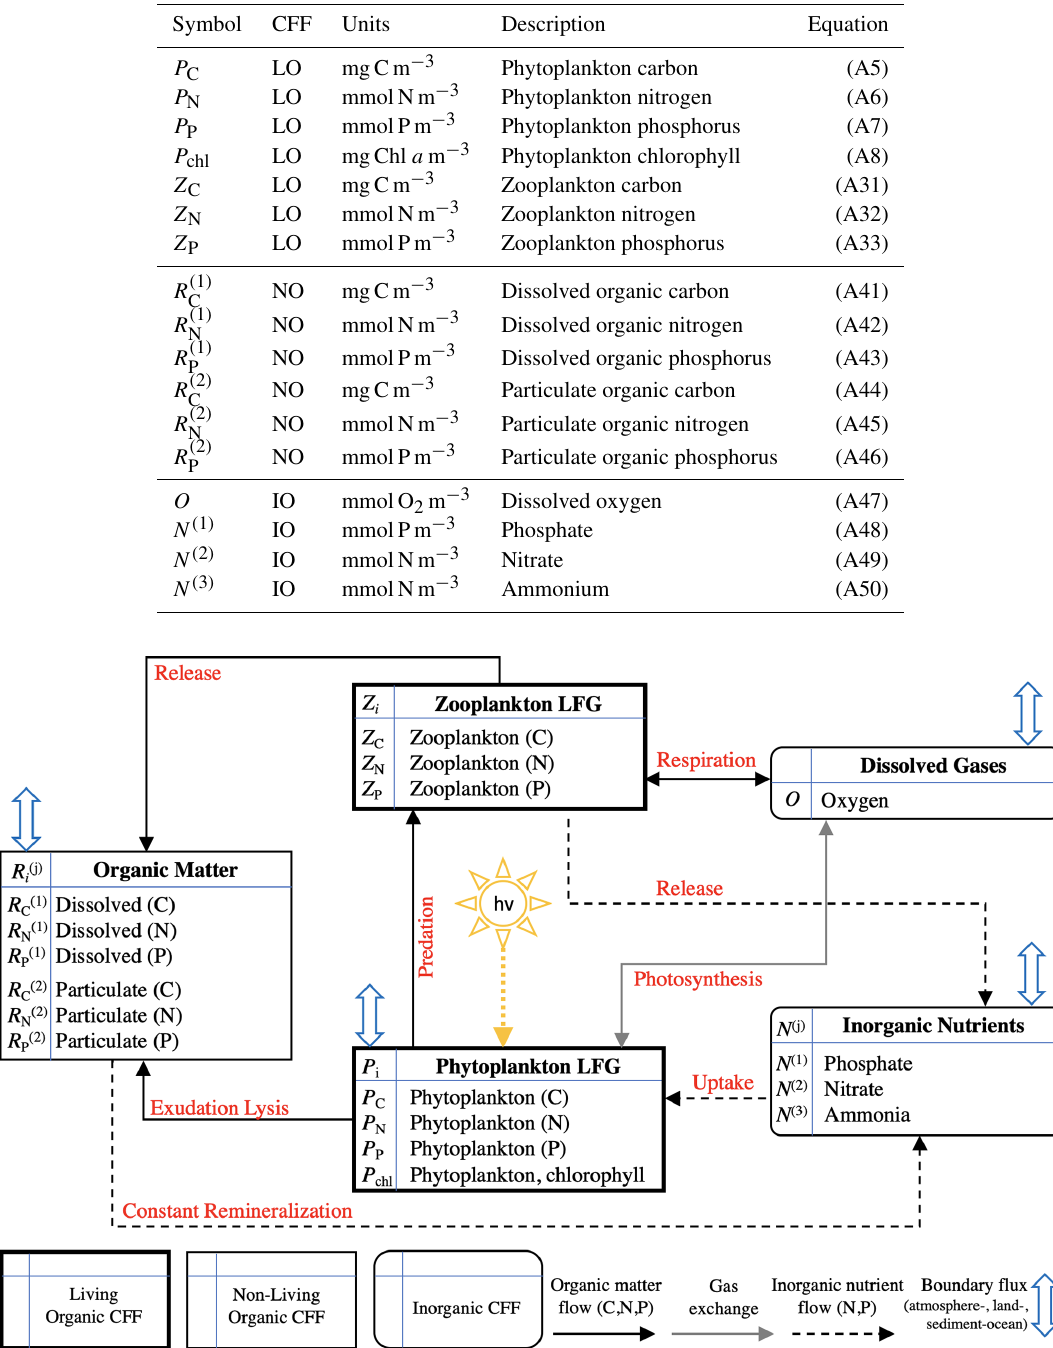
Figure 1. Schematic of the 17-state-equation BFM17 model. The dissolved organic matter, particulate organic matter, and living organic matter CFFs are each comprised of three chemical constituents (i.e., carbon, nitrogen, and phosphorus). The living organic CFF is further subdivided into phytoplankton and zooplankton living functional groups